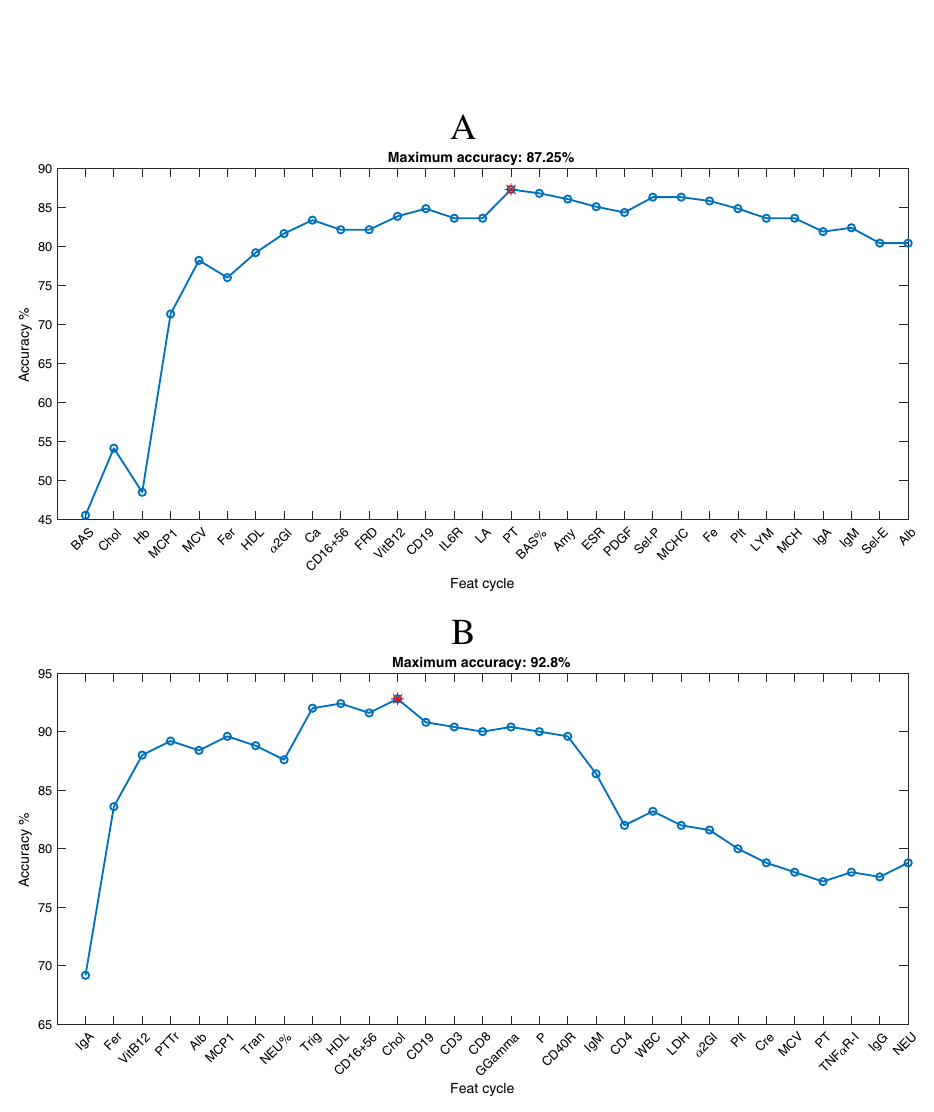
Figure 3. Classification accuracy trend of the low versus high progression rate recognition model as a function of the first 30 selected blood analytes. The red marker indicates the maximum accuracy. ( A ) The result achieved on the ALS dataset (i.e., maximum accuracy of 87.25% combining the first 16 ranked features). ( B ) The result achieved on the LMND dataset (i.e., maximum accuracy of 92.80% combining the first 12 ranked